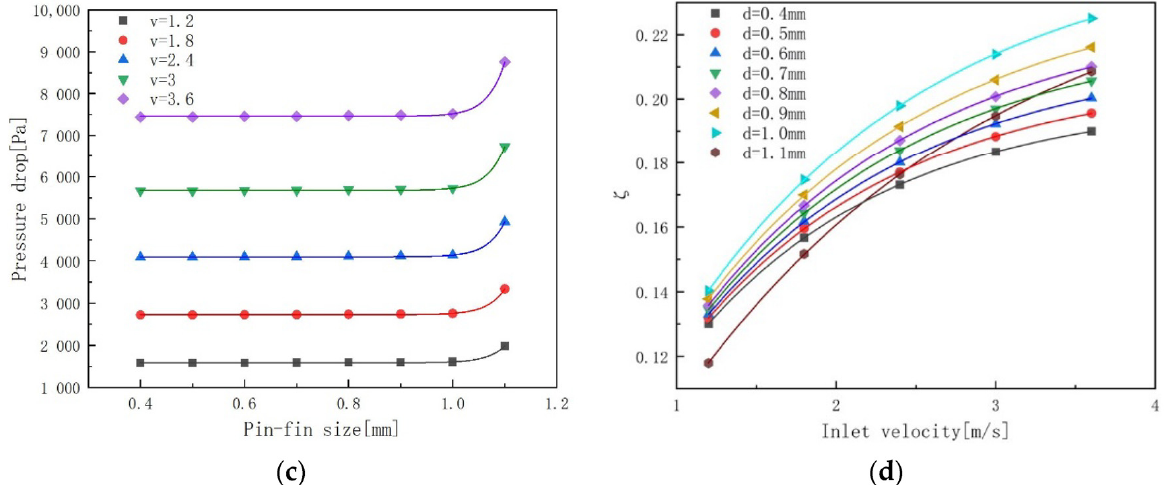
Figure 12. Flow and heat transfer performance of the double-layer MMC with various pin– fin sizes: ( a ) thermal resistance; ( b ) maximum temperature difference; ( c ) pressure drops; and ( d ) comprehensive